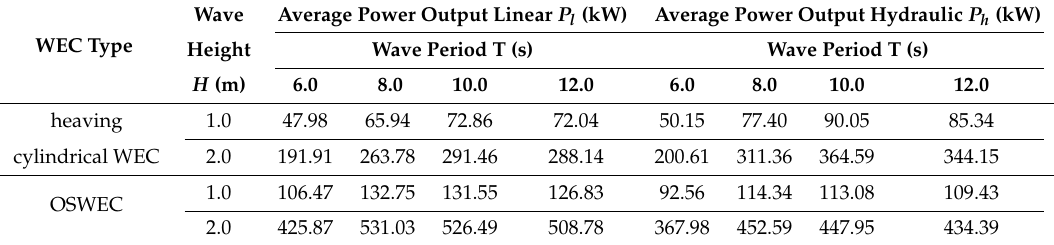
Table 4. Average power output for a single WEC for a linear and hydraulic PTO system. Heaving cylindrical WEC: top two rows. OSWEC: bottom two